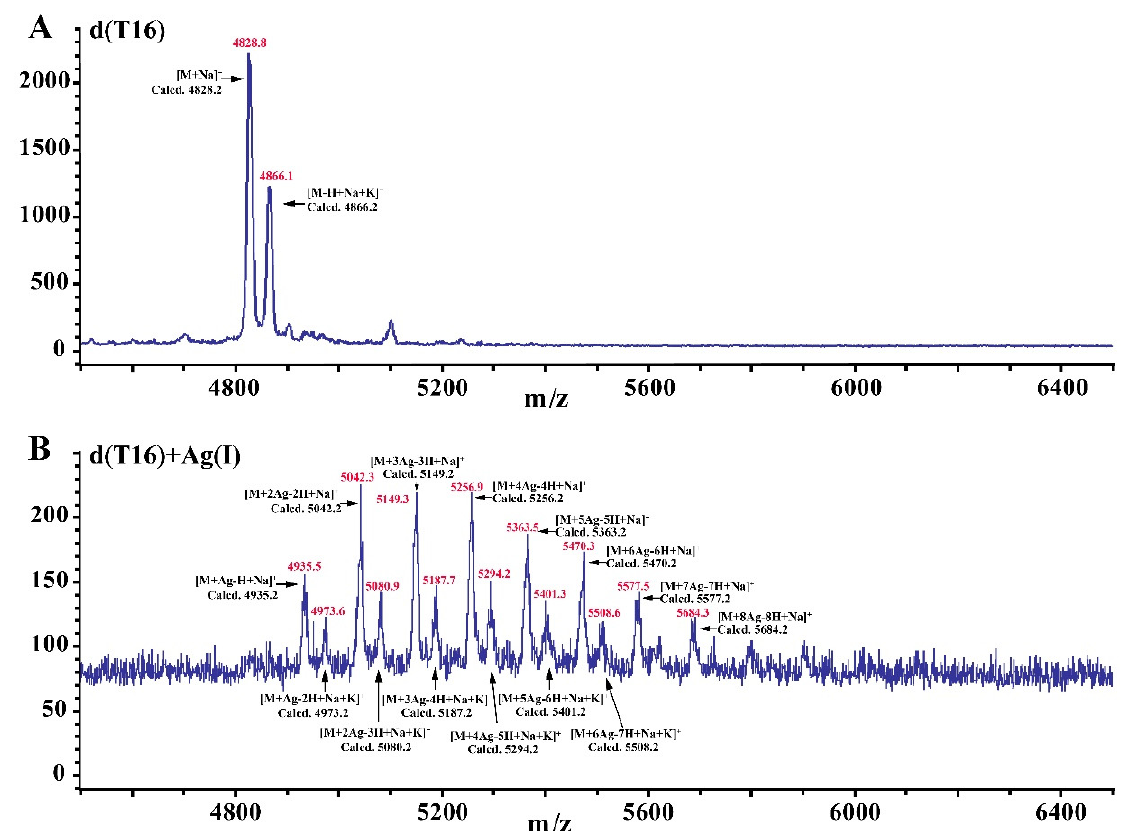
Figure 5. Positive MALDI-TOF/MS spectra of 100 µ M pT16 in the absence ( A ) and presence ( B ) of 800 µ M AgNO 3 . The reaction conditions are the same as those for Figure 1.